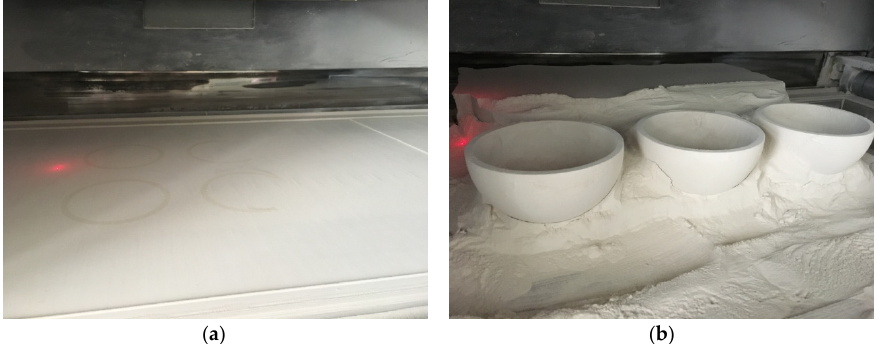
Figure 3. ( a ) Printing the hemispherical greenbodies in the additive manufacturing (AM) equipment, and ( b ) the printed hemispherical greenbodies.